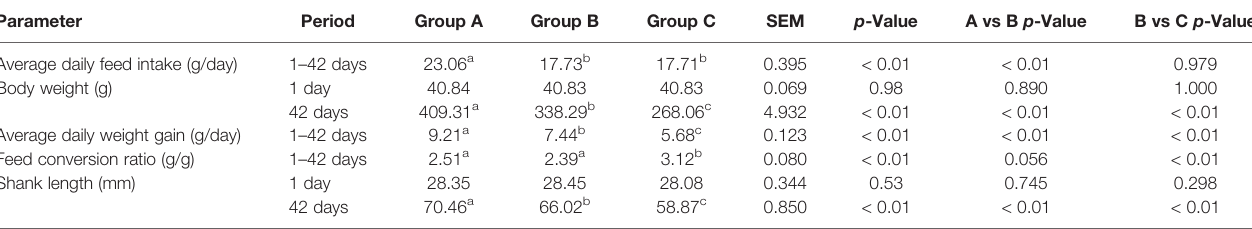
TABLE 1 | The effects of combined OTA and AFB1 on the growth performance in pullets (n = 6, mean ± SEM). Parameter